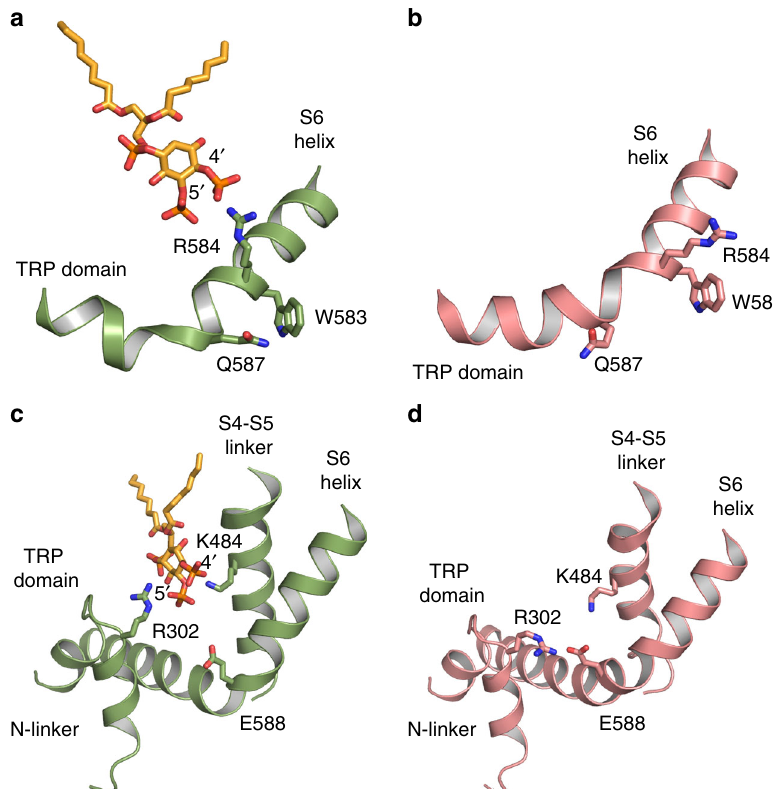
Fig. 4 Interactions of TRPV5 with PI(4,5)P 2 . a View of the lower S6 helix and TRP domain of PI(4,5)P 2 -bound TRPV5. The PI(4,5)P 2 -bound TRPV5 is shown in green and the PI(4,5)P 2 in orange. b View of the lower S6 helix and TRP domain of the lipid-bound TRPV5 structure (pink). c The 5 ’ phosphate of PI(4,5) P 2 (orange) interacts with R302 of the N-linker and K484 of the S4-S5 linker in the PI(4,5)P 2 -bound TRPV5 structure. d The lipid-bound structure showing the N-linker, S4-S5 linker, S6 helix, and TRP domain in